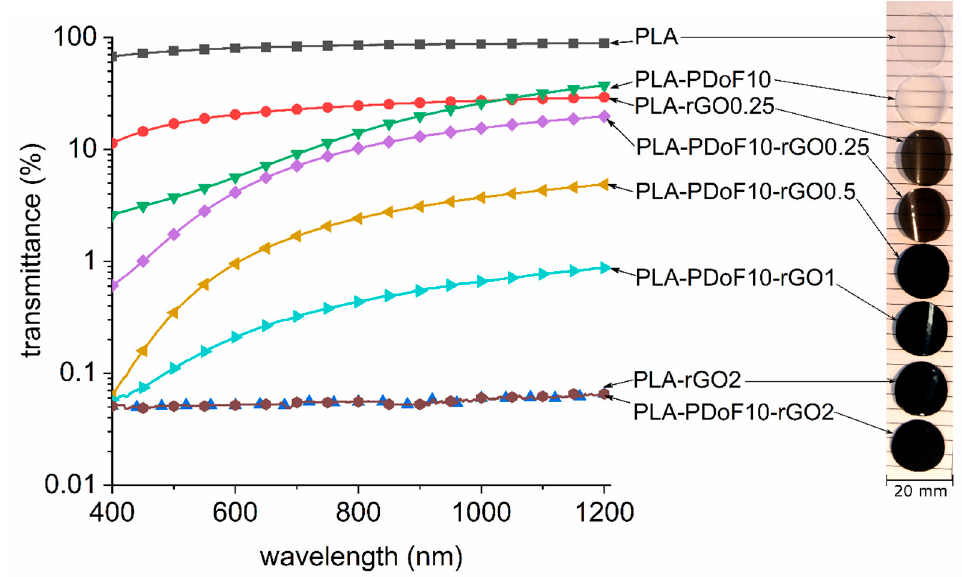
Figure 12. Log-scale transmittance spectra and representative pictures of the prepared films.